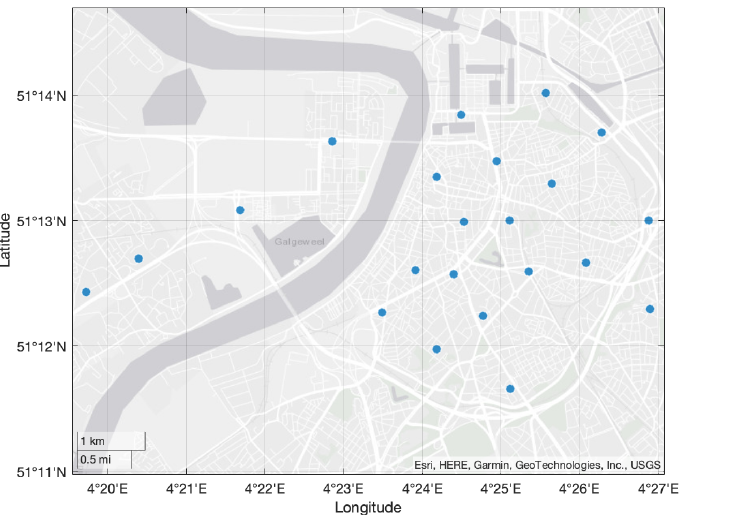
Figure 3. Geometrical Medians of Clusters obtained with kNN